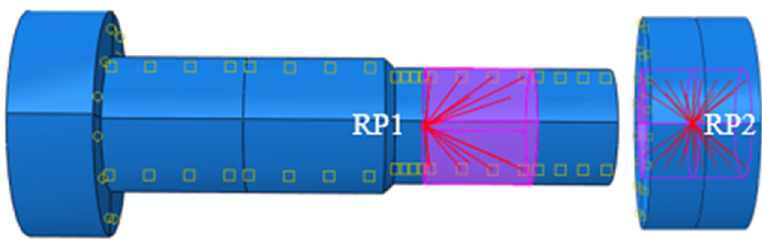
Figure 5. Thread and nut reference points (RP).